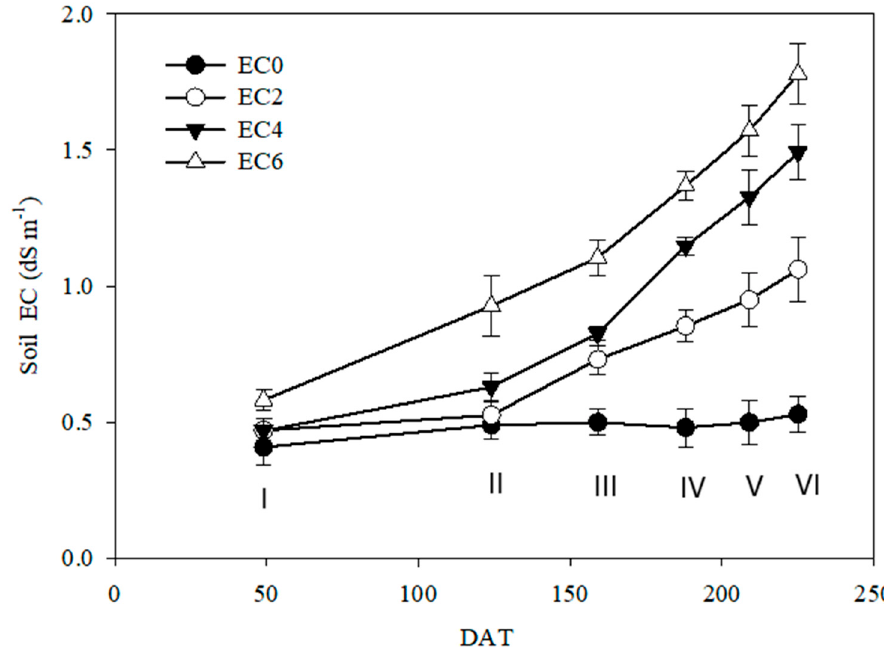
Figure 1. Trends in soil electrical conductivity (dS m − 1 ) over the six harvesting times (I–VI). Vertical bars above each mean indicate standard deviation (SD; n = bars above each mean indicate standard deviation (SD; n = 3).